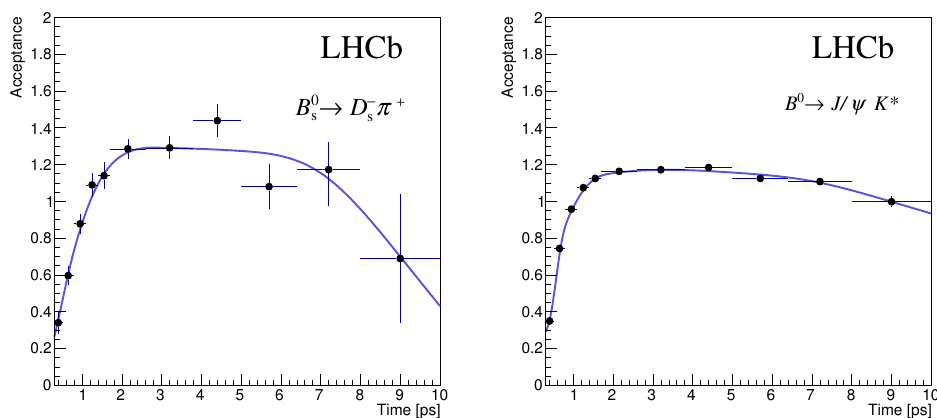
Figure 4 . Decay-time acceptances calculated from (left) B 0 and (right) B 0 ! J= K (cid:3) 0 decays to match Run 2 data. Superimposed is a parameterisation using cubic